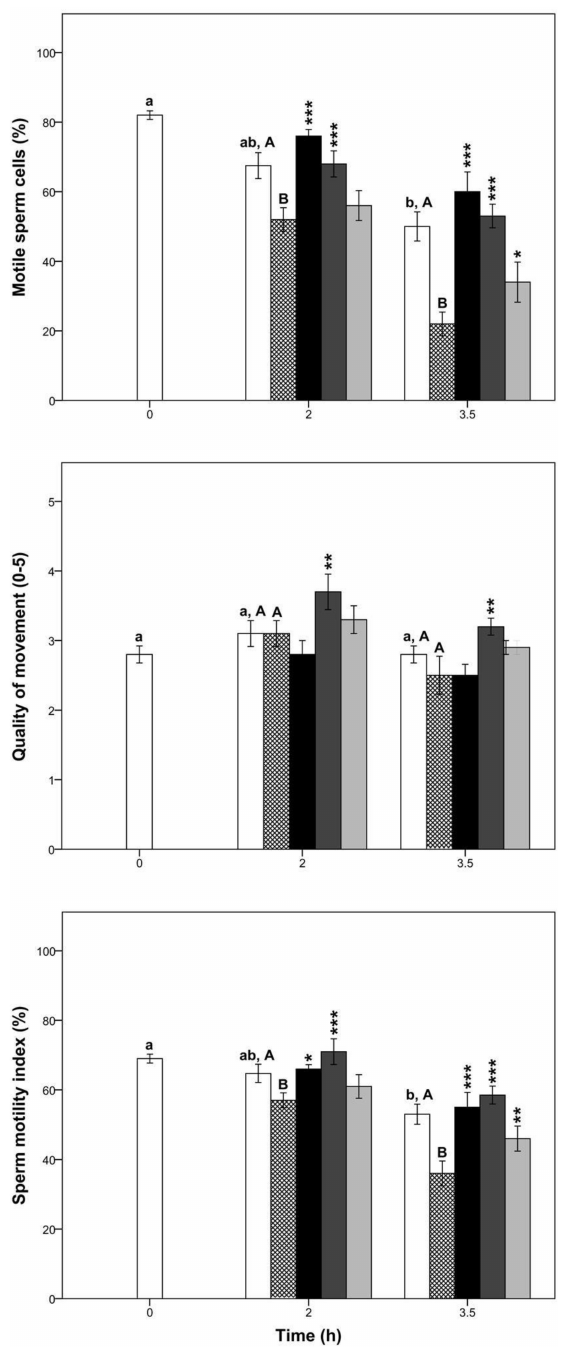
Figure 1. Percentage of motile sperm cells, quality of movement, and sperm motility index in boar samples submitted to oxidative stress (CTR except) and supplemented with aminoguanidine. Different superscript lower-case letters indicate significant differences ( p < 0.05) among times for the control group without induced oxidative stress. Different superscript upper-case letters indicate significant differences ( p < 0.05) between the control group with and without induced oxidative stress within each given time. The asterisks indicate significant differences between the treatment and the control submitted to induced oxidative stress within each given time (* p < 0.05; ** p ≤ 0.01; *** p ≤ 0.001). White bars = control samples; crossed bars = control samples under induced oxidative stress; black bars = 10 mM aminoguanidine; dark grey bars = 1 mM aminoguanidine; and light grey bars = 0.1 mM aminoguanidine. Data are shown as mean ± standard error of 5